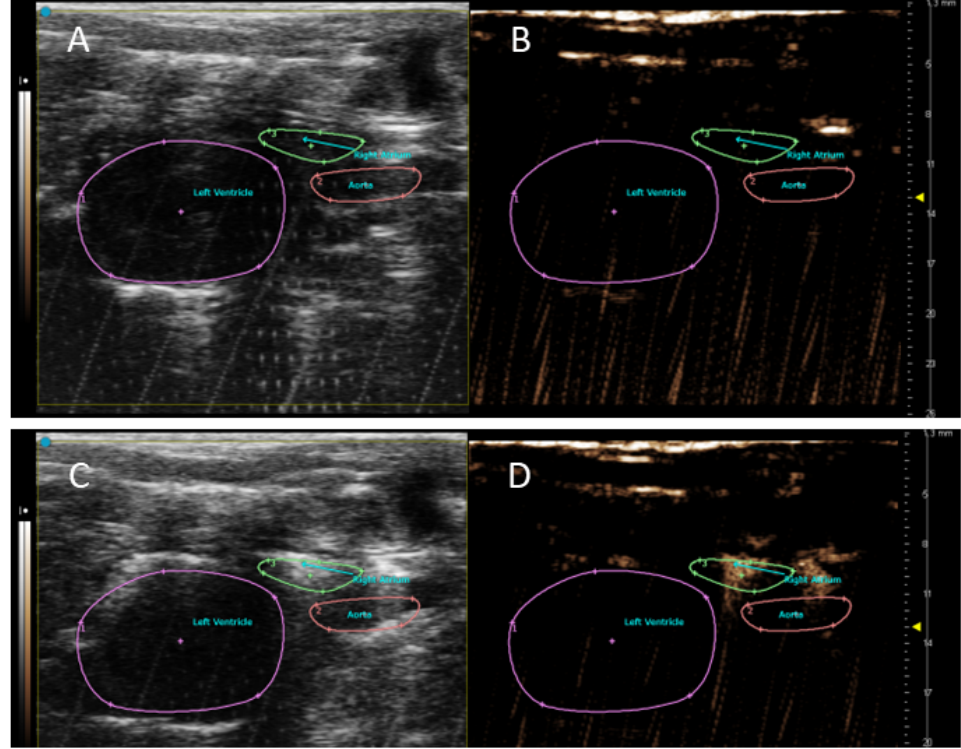
Figure 3. NLC imaging of rat heart with CO 2 foam in PSLAX view. The experimental rat was cannulated in the inferior vena cava (IVC). The heart before ( B ) and 5 s after administration ( D ) of 2 mL of CO 2 foam. Corresponding images in B-Mode are in the left panel ( A , C ). The NLC signal was observed inside the right atrium (green) and pulmonary artery. The cannulated infrarenal aorta (Figure 4) was only a useful approach for the admin- istration of Vevo MicroMarker™. The administration of 2 mL of CO 2 foam into the infrare- nal aorta did not affect the NLC signal in the heart chambers.